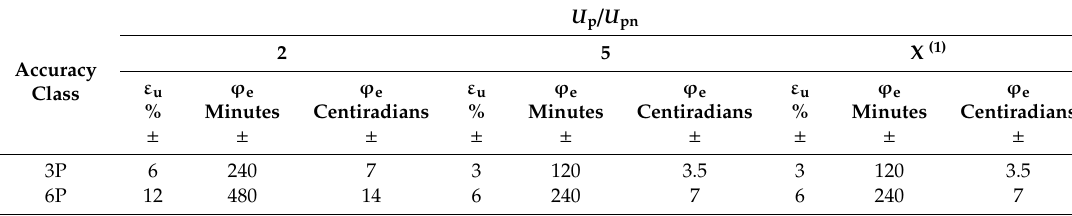
Table 2. Protection class accuracy requirements [5]. In the table, U p and U pn are the primary voltage and nominal(rated)primaryvoltage,respectively; ε u and ϕ e arethevoltage(ratio)andphaseerrors,respectively.